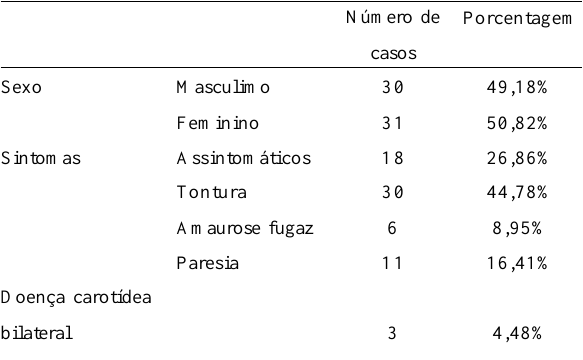
Tabela 1. Perfil demográfico e sintomatologia pré-operatória